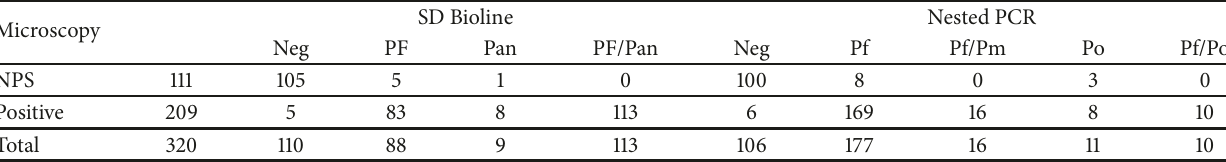
Table 2: Microscopy and SD Bioline (cid:2) mRDT diagnosis results compared to nested PCR.